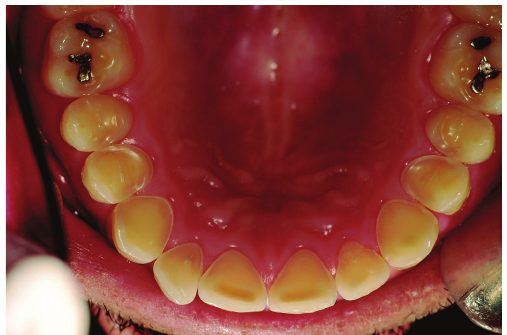
Figure 2: The posterior quadrant view of mandibular teeth with flatted occlusal surfaces.